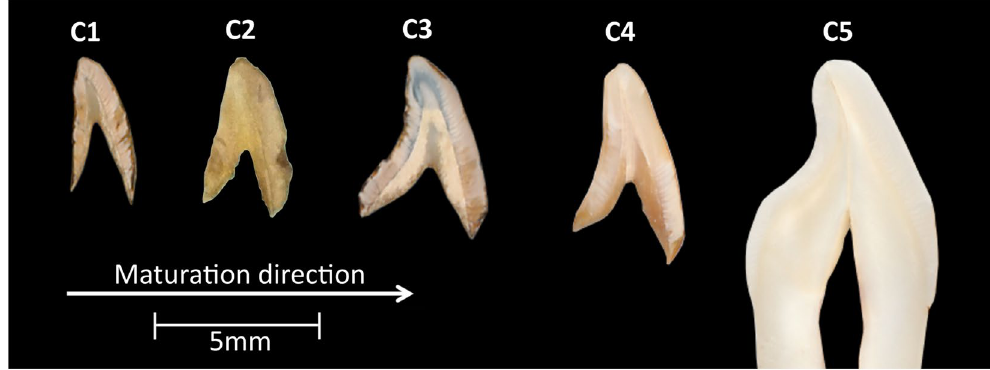
Figure 10. Photographs of the 0.3 mm thick slices of human permanent maxillary central incisors at various developmental stages. For each tooth section, labial is on the right hand